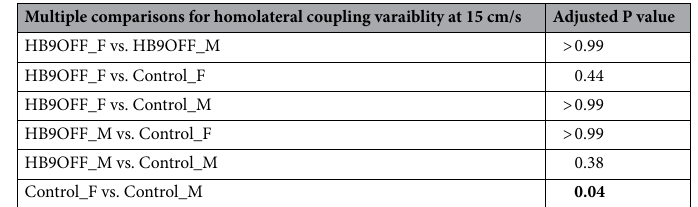
Table 3. Statistics for multiple comparison of sex × genotype for the homolateral coupling variability at 15 cm/s using Bonferroni correction. Bold indicates significant P values. See “Methods” for details.